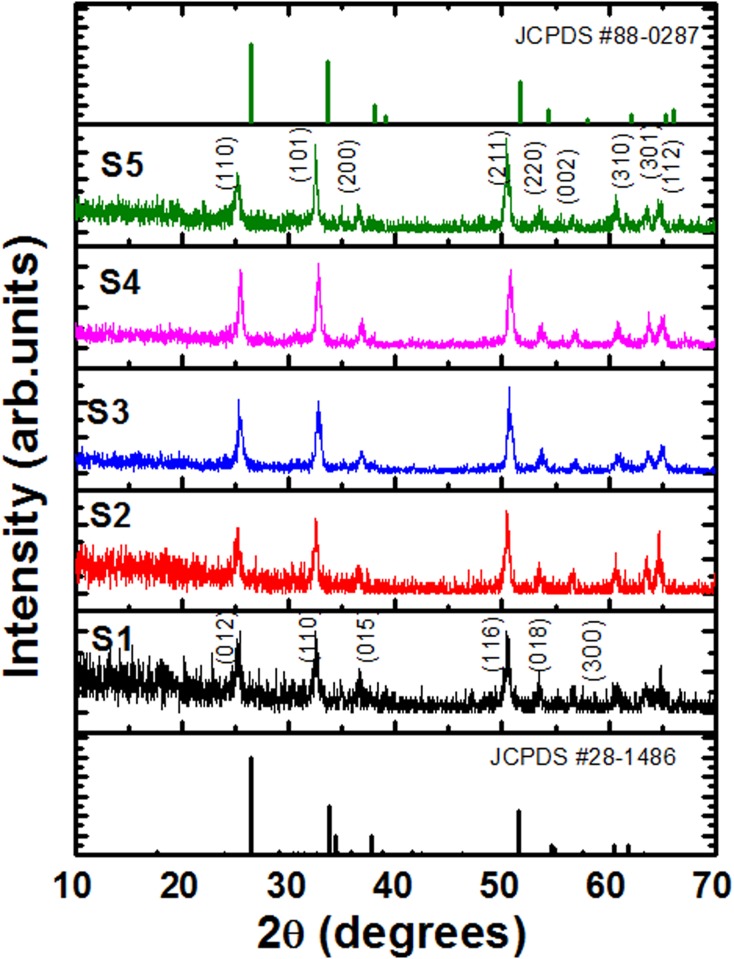
X-ray diffraction patterns of samples S1, S2, S3, S4, and S5 i.e., of the ZnSnO3, Zn1.25SnO3+α, Zn1.5SnO3+β, Zn1.75SnO3+γ, Zn2SnO4 nano-crystallites, respectively obtained by decomposition of the gel product (formed through wet chemistry reaction at 100°C for 18 h) at 650°C for 3h.